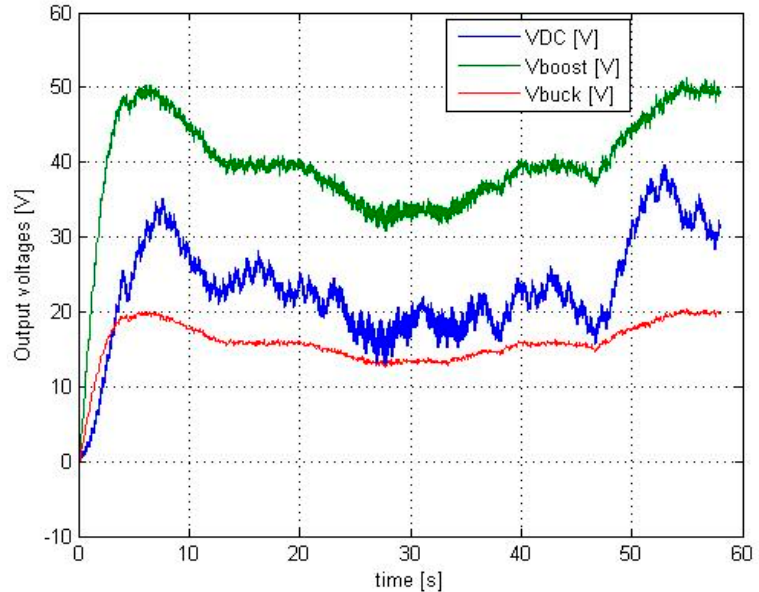
Figure 9. Rectifier DC voltage: Vdc (blue); boost converter output voltage: Vboost (green); buck converter output voltage: Vbuck (red).